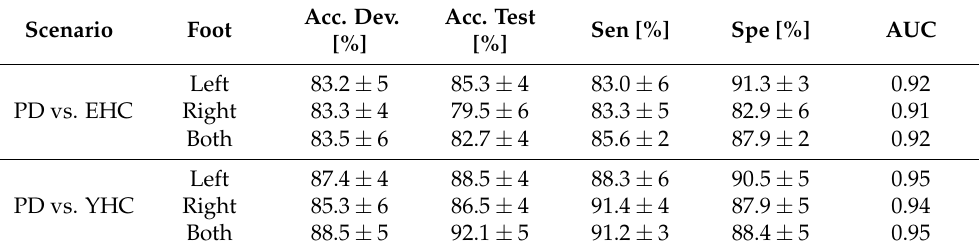
Table 3. Results using CNN and 4 × 10 m